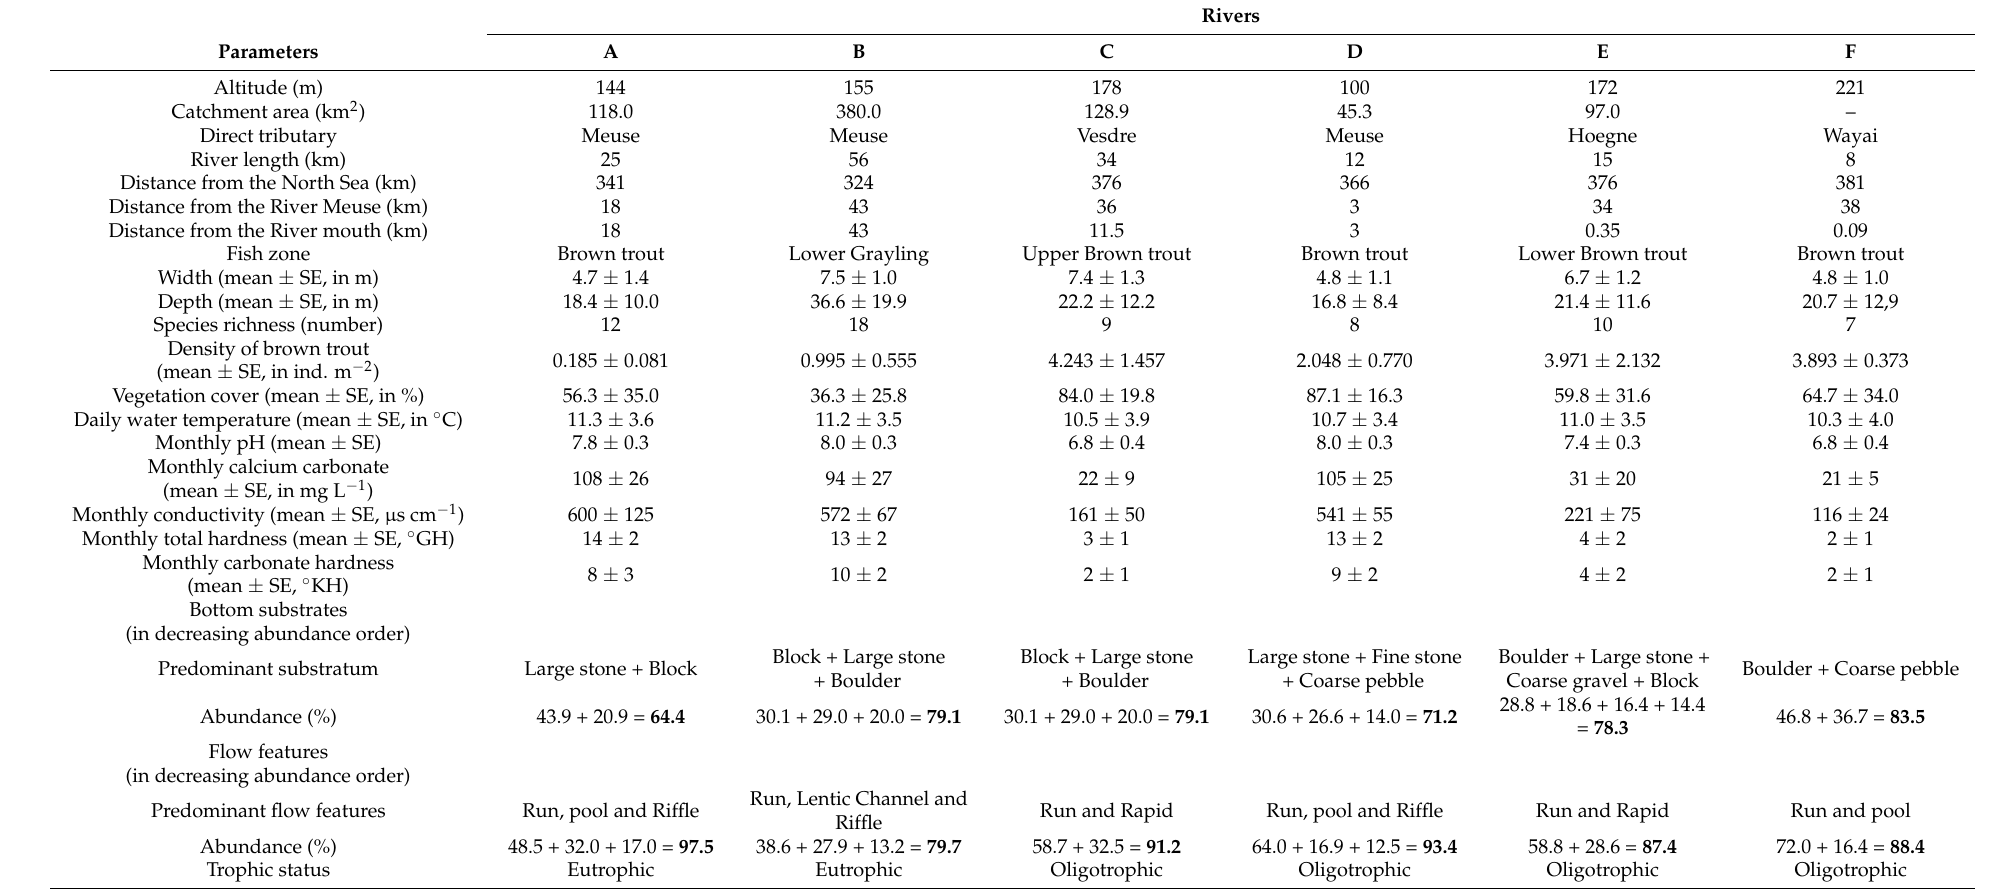
Table 1. Description of the study areas. The bottom substrate particle sizes (in cm, the diameter perpendicular to the longest axis) are: boulders (>102.4), blocks means standard error; ind. indicates individuals. The daily and monthly values were calculated based on data collected from 2017 to